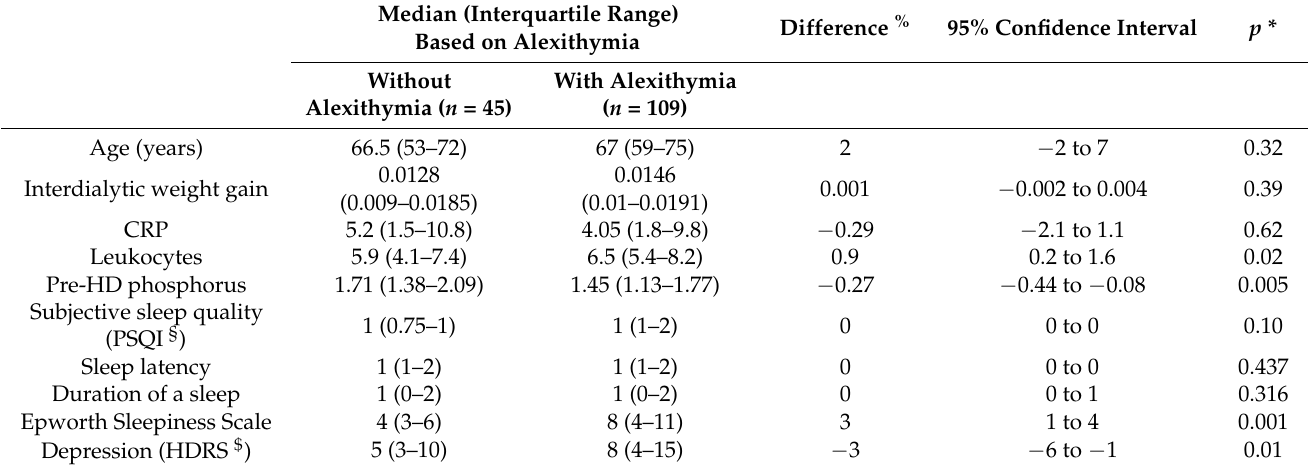
Table 8. Differences in interdialytic weight gain and pre-hemodialysis biochemical